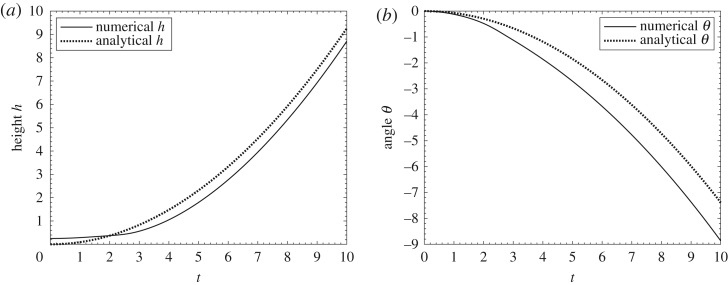
(a) Comparison between numerical and long-time analytical solutions for (a) scaled height h, (b) scaled angle θ for a fly-away case. Body has symmetric parabolic shape fu = x(1 − x), σ = 0.5, scaled mass M^=1, moment of inertia I^=0.2, and g^=0.1.